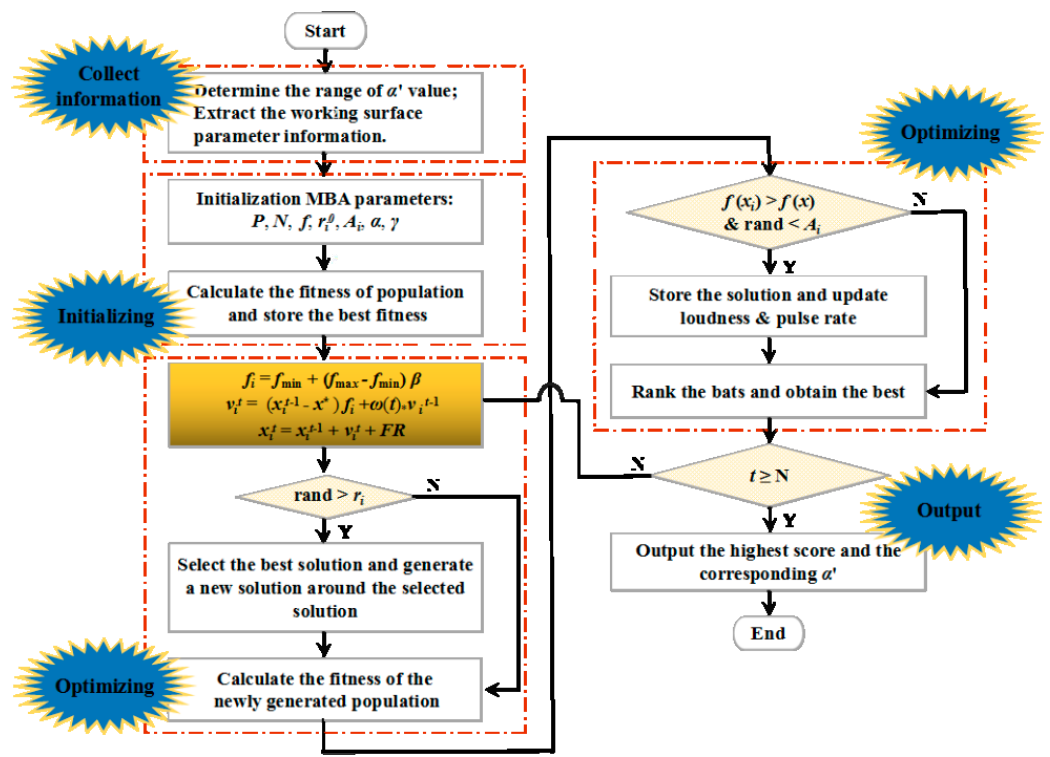
Figure 4. The flowchart for optimizing horizontal bending angle of S-bending area based on MBA.